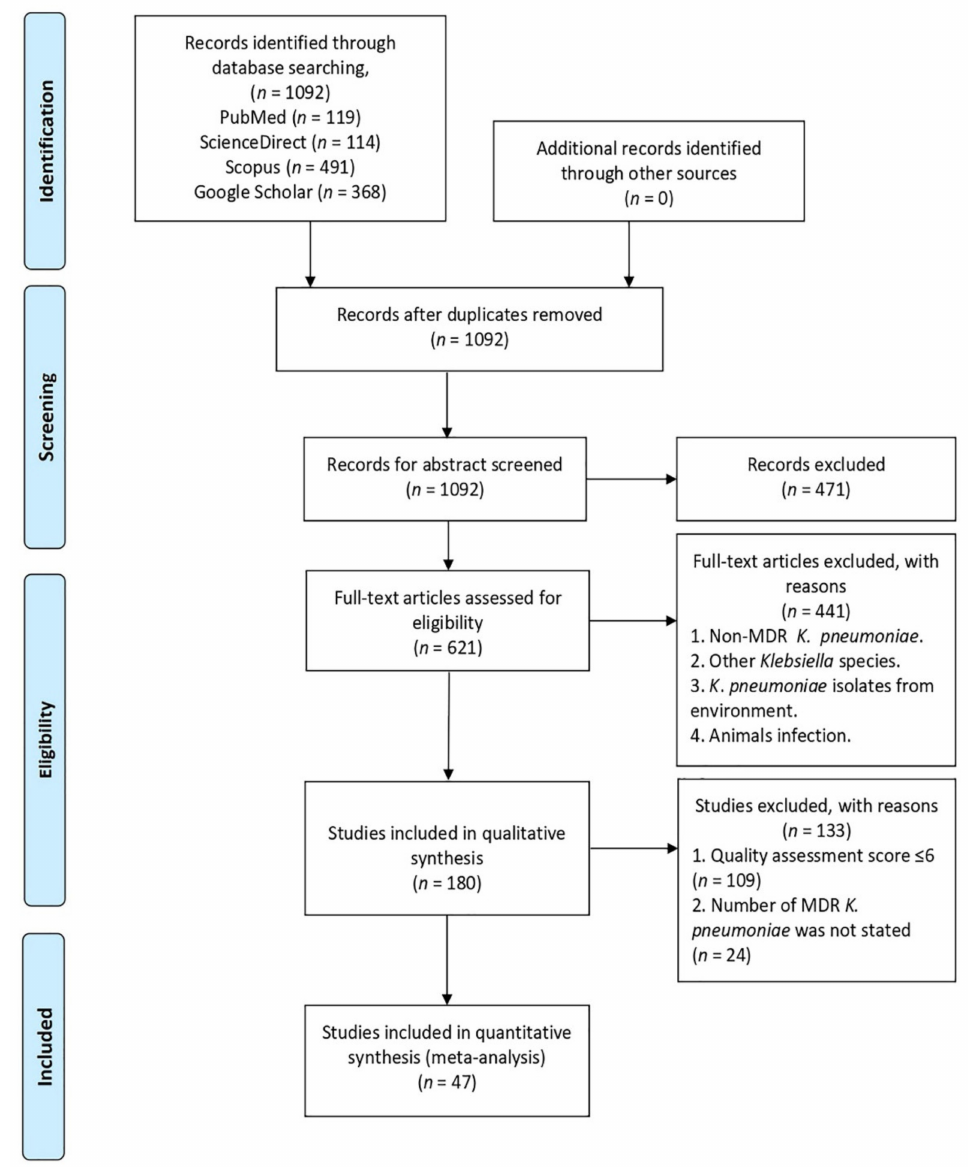
Figure 1. PRISMA flow diagram illustrating the selection process of the studies in this